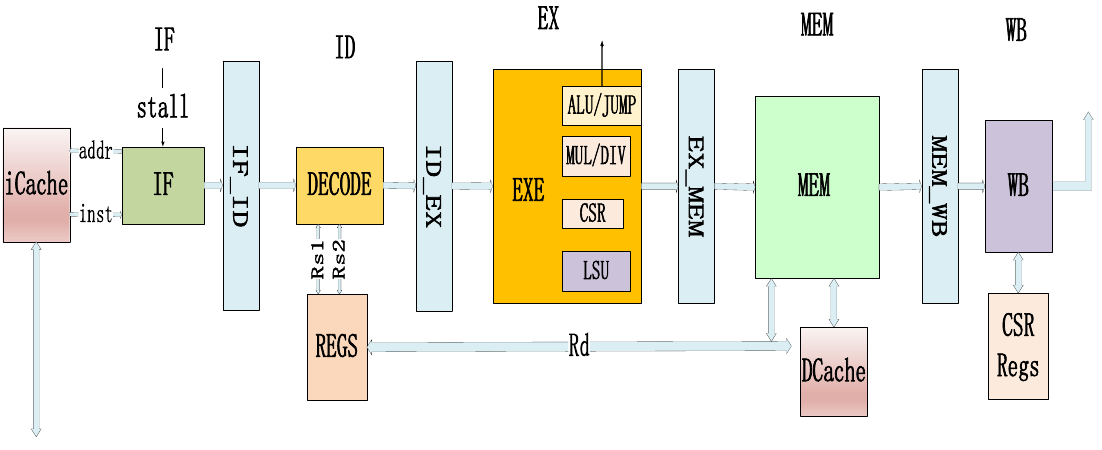
Figure 1. Rv32IM processor core architecture.